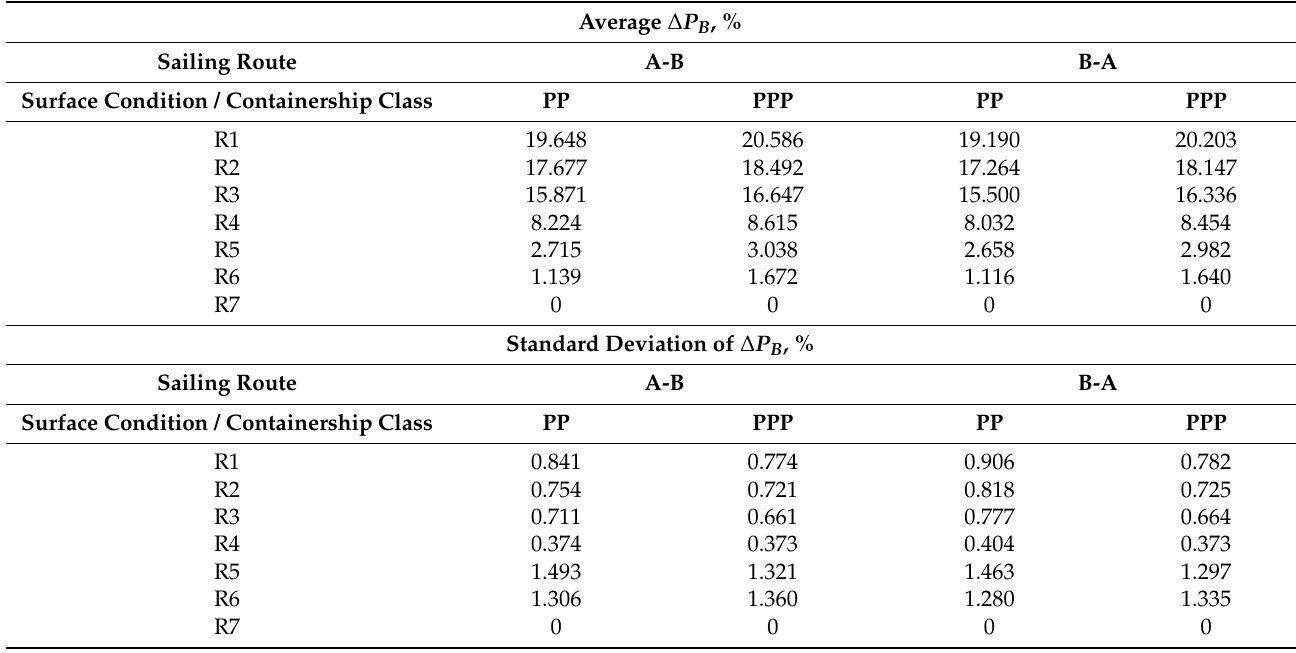
Table 3. The obtained increases in P B for PP and PPP containership